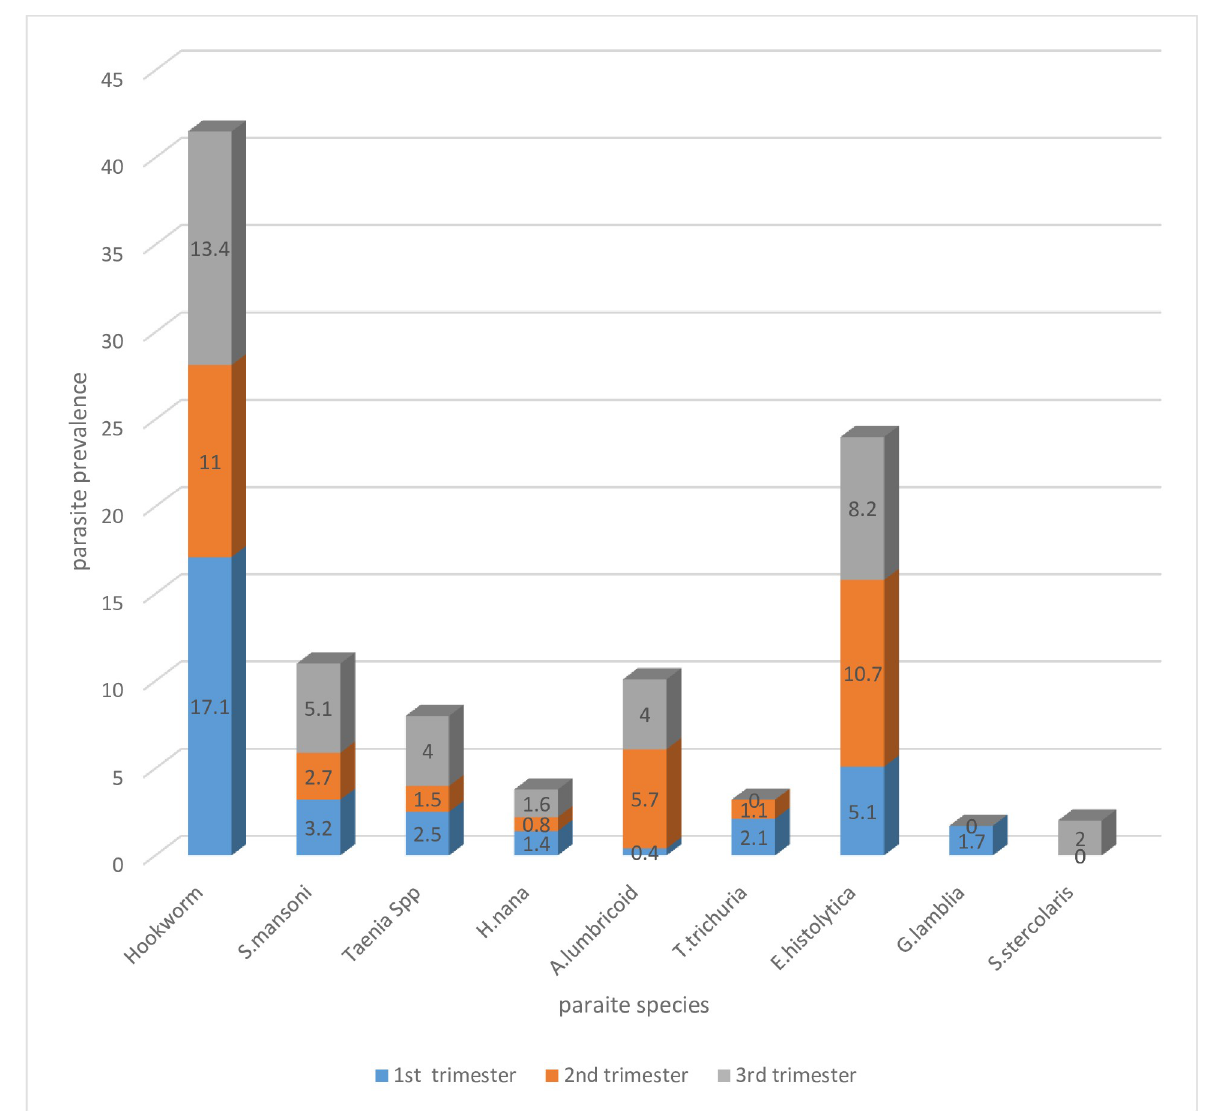
Fig 1. The distribution of intestinal parasites stratified by trimester among pregnant women at Debre Markos Referral Hospital, Ethiopia. https://doi.org/10.1371/journal.pone.0250990.g001 pregnant women of the second trimester was 13/263 (4.9%). Among intestinal parasite- infected second trimester pregnant women, 12/87 (13.8%) of them were anemic. From these, mild and moderate anemia account for 8/87(9.2) and 4/87(4.6%), respectively. Only one per- son was anemic among intestinal parasite-free pregnant women. There was a significant differ- ence in the mean hematological profiles between intestinal parasite-infected and non-infected pregnant women. Intestinal parasite-infected pregnant women were HGB = 12.8g/dl, HCT = 37.9%, MCV = 94.9fl, MCH = 33.7pg, MCHC = 35.3g/dl and t HGB = 14.8g/dl, HCT = 40.5%, MCV = 95.1fl, MCH = 33.6 pg, and MCHC = 35.5g/dl for intestinal parasite- free pregnant women.